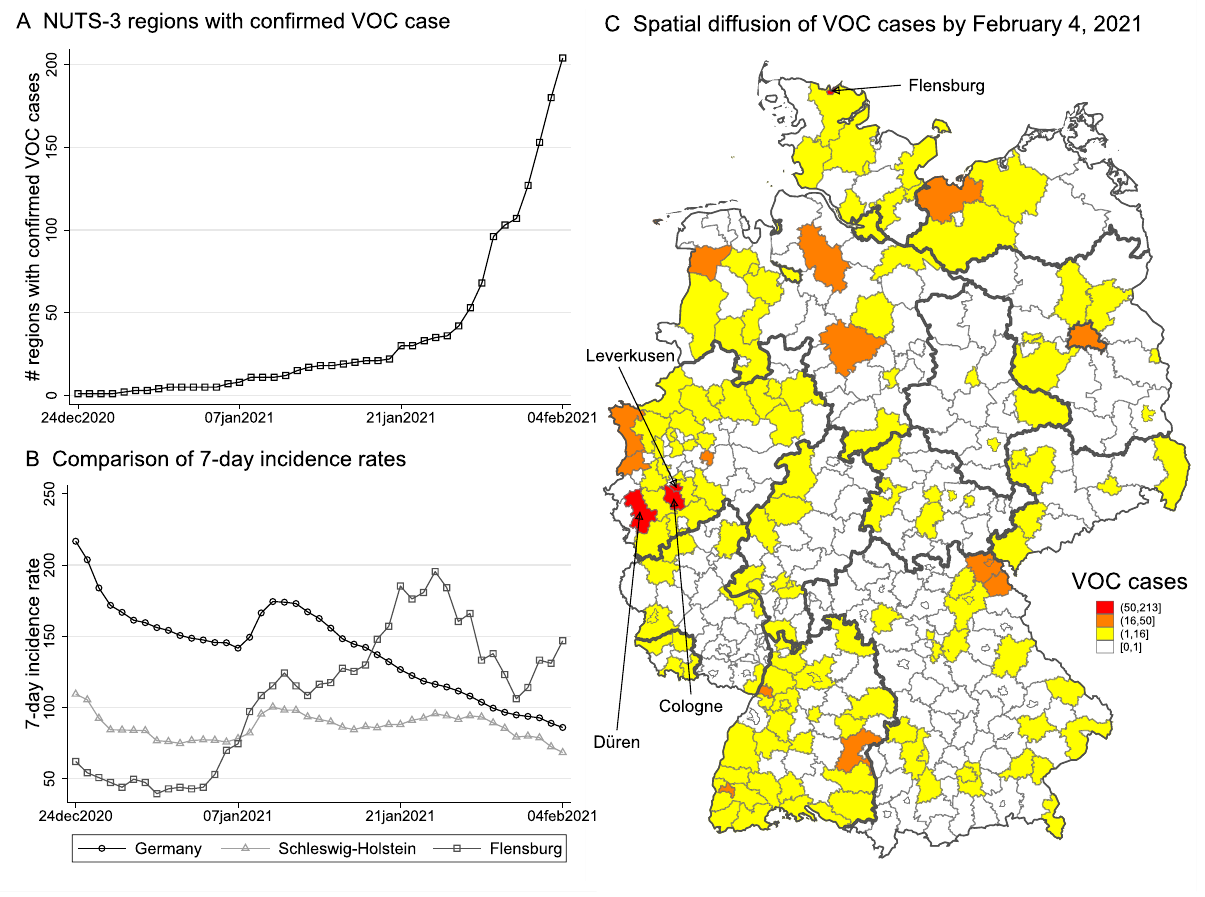
Figure 1. Temporal and spatial distribution of VOC cases in Germany. Panel ( A ) counts NUTS-3 regions with confirmed VOC cases over time. Panel ( B ) compares the 7-day incidence rate (by day of reporting) for Germany, Schleswig-Holstein, and Flensburg. Panel ( C ) shows the spatial spread of VOC cases by February 4, 2021. Flensburg and Cologne, Düren and Leverkusen report most confirmed